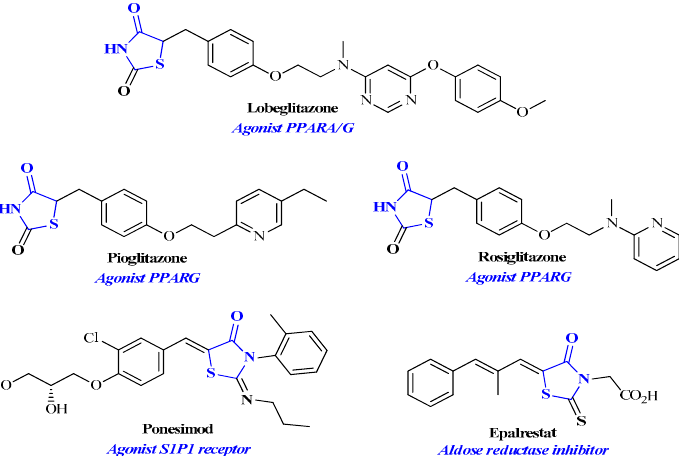
Figure 1. Structures of approved 4-thiazolidinone-based drugs.